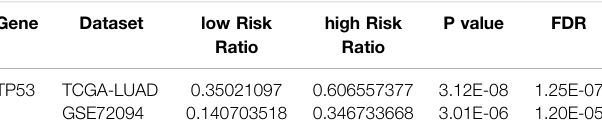
TABLE 1 | TP53 frequency status in high and low risk groups in TCGA-LUAD and GSE72094 datasets. Gene Dataset low Risk